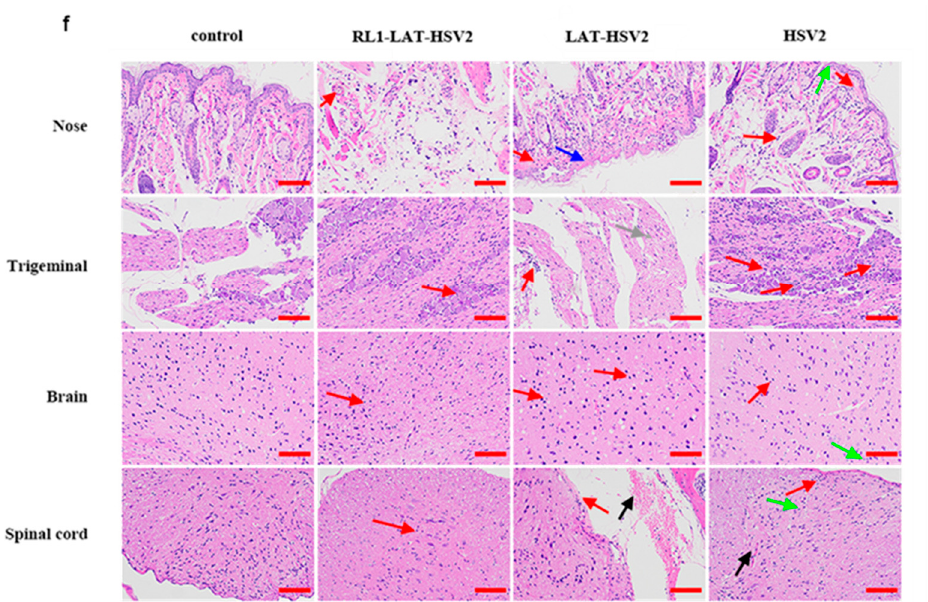
Figure 2. Clinical manifestations of mice infected with RL1-LAT- HSV-2 and LAT- HSV-2. ( a ) Body weight following vaginal challenge with RL1-LAT- HSV-2 (orange line), LAT- HSV-2 (green line) or HSV-2 (purple line). ( b ) Survival rate following vaginal challenge with RL1-LAT- HSV-2, LAT- HSV-2 or HSV-2. ( c ) Body weight following nasal challenge with RL1-LAT- HSV-2, LAT- HSV-2 or HSV-2. ( d ) Survival rate following nasal challenge with RL1-LAT- HSV-2, LAT- HSV-2 or HSV-2. ( e ) Pathological changes in the vaginal and nerve tissues of mice infected with RL1-LAT- HSV-2, LAT- HSV-2 or HSV-2 via vaginal challenge. Red arrows indicate the infiltration of inflammatory cells. Yellow arrows and blue arrows indicate the death of cells. Green arrows indicate the cytoplasmic vacuolization of cells. Black arrows indicate hyperemia. Samples were obtained at 5 days postinfection. Scale bar: 100 µ m. ( f ) Pathological changes in the nose and nerve tissues of mice infected with RL1-LAT- HSV-2, LAT- HSV-2 or HSV-2 via nasal challenge. Red arrows indicate the infiltration of inflammatory cells. Blue arrows indicate the death of cells. Green arrows indicate the cytoplasmic vacuolization of cells (Cytoplasmic vacuolization can a ff ect the normal function of cells, it is a symbol that cells are in poor condition and can even lead to cell death). Black arrows indicate hyperemia. Gray arrows indicate loose cytoplasm (Loose cytoplasm means cellular swelling and damage). Samples were obtained at 5 days postinfection. Scale bar: 100 µ m. The data are shown as the mean ± SD. Statistical significance was measured by the log-rank test. * p < 0.05, ** p < 0.01; *** p <